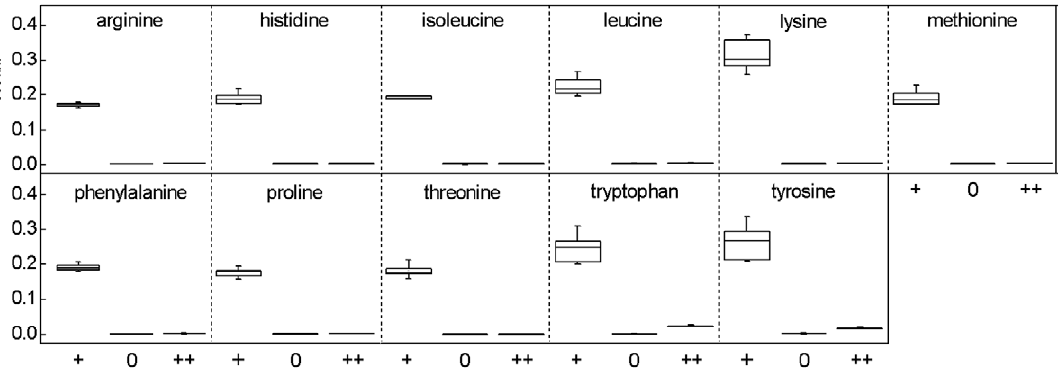
Figure 1. Confirmation of the biosensors’ auxotrophy. The eleven biosensors were grown in minimal medium, which was supplemented with 3 mM of the required focal amino acid ( + ), devoid of any amino acid supplementation ( 0 ), or supplemented with 3 mM of each of the 19 other, proteinogenic amino acids ( ++ ). Growth of eight replicates was determined turbidometrically (OD 600 nm ) after 18 h (histidine, arginine, tryptophan, isoleucine, methionine, phenylalanine, tyrosine, proline, and lysine) or 24 h (leucine and threonine) of cultivation. Boxplots: median (horizontal lines in boxes), interquartile range (boxes), 1.5-fold interquartile range (whiskers).